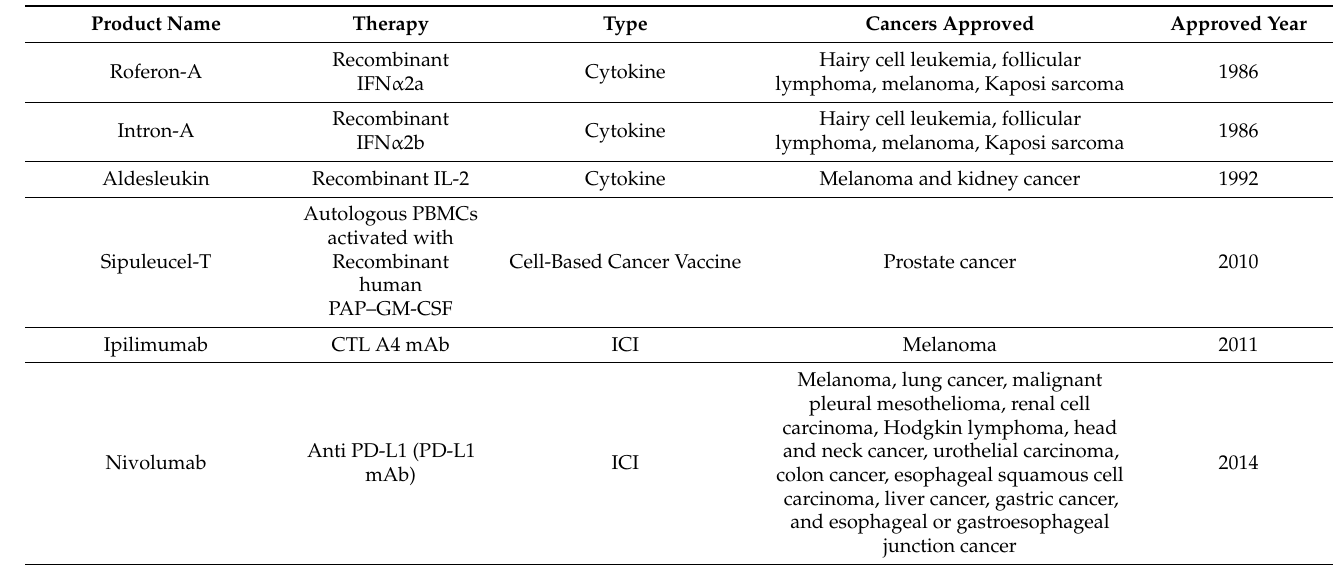
Table 1. Cancer Immunotherapy Products on the Market Approved by the US FDA